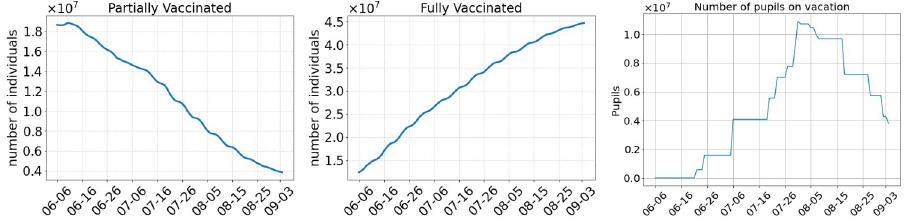
Fig 3. Left: Number of individuals that have received the first dose of the vaccine at least two weeks ago and who are not yet fully vaccinated. Center: Number of individuals that have received their second dose of the vaccine at least seven days ago. Right: Number of pupils that are currently on summer